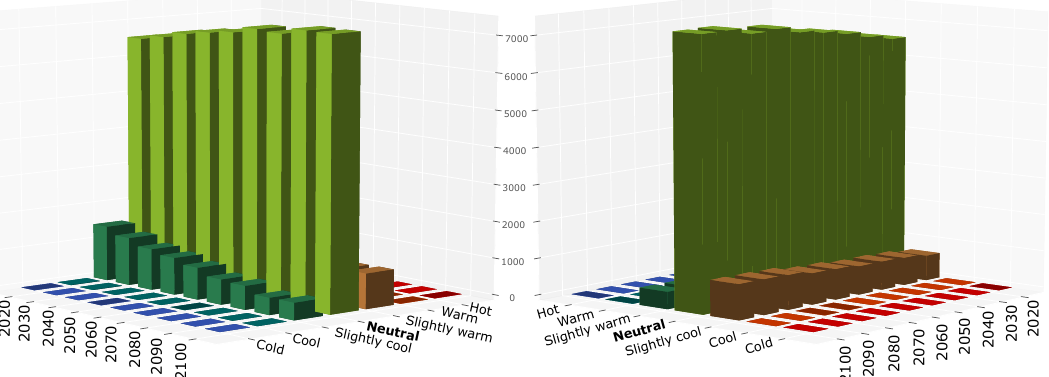
Figure 9. Comfort results taking into account the CTE-2019 standard and the Pamplona weather file generated with Meteonorm based on the IPCC scenario